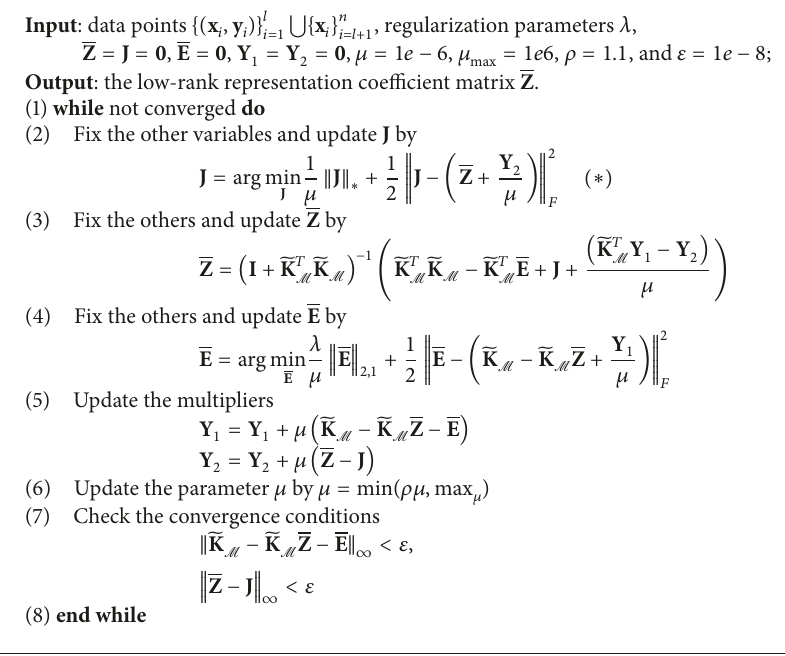
Algorithm 1: Optimization to